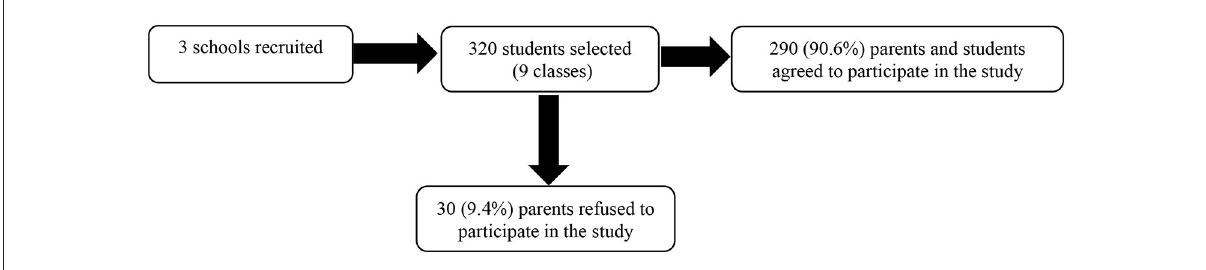
FIGURE1 Sampling procedure flow